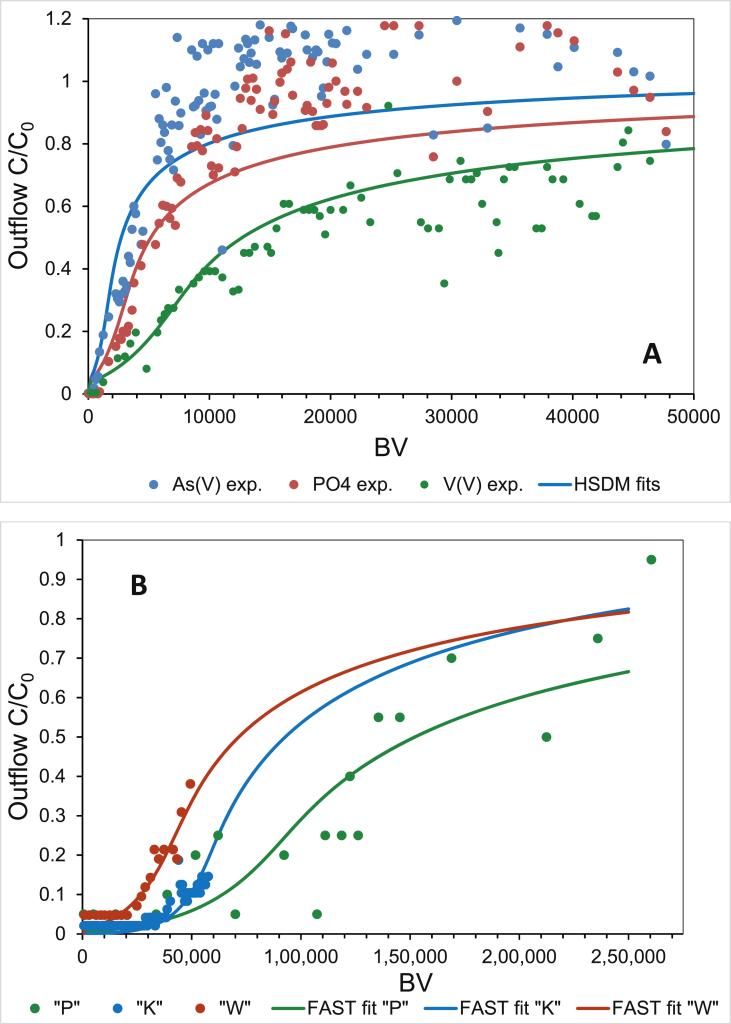
Breakthrough curves for (A) the RCSST experiments, and (B) the pilot scale FBAs (the dots represent experimental data), with lines fitted using the HSDM option of the FAST v.2.1 software code with the parameters compiled in Table 2, Table 3.